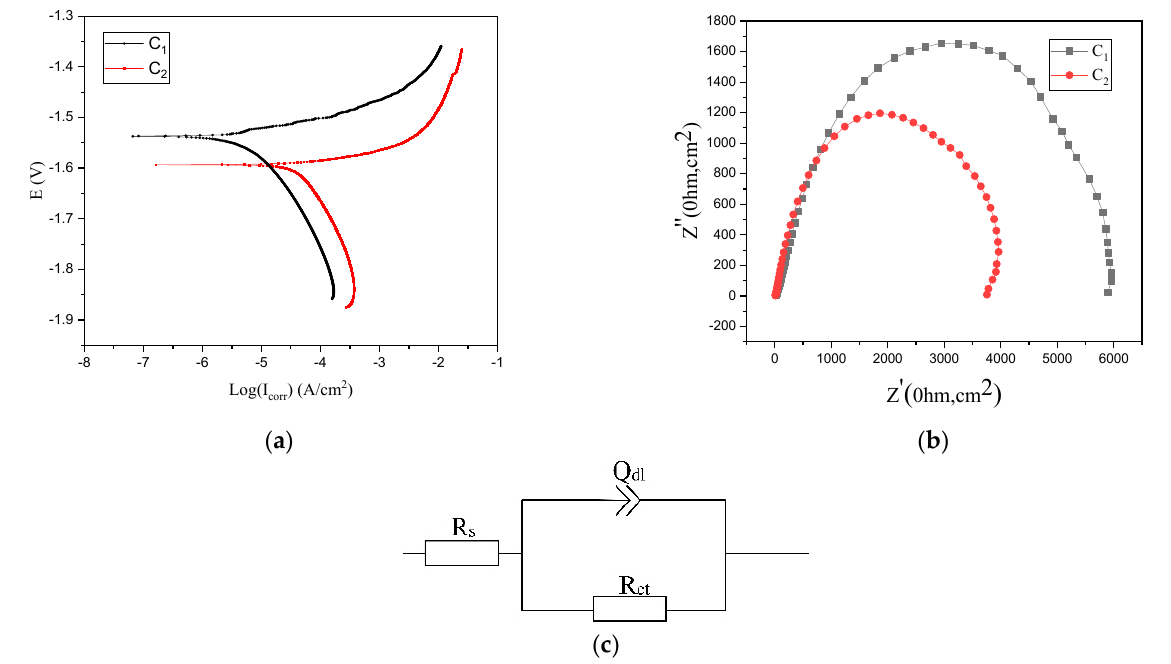
Figure 3. Electrochemical measurements: ( a ) potentiodynamic polarization curves, ( b ) electrochem- ical impedance spectra, ( c ) equivalent circuit models for fitting EIS. Table 1. Fitted results of potentiodynamic polarization curves.